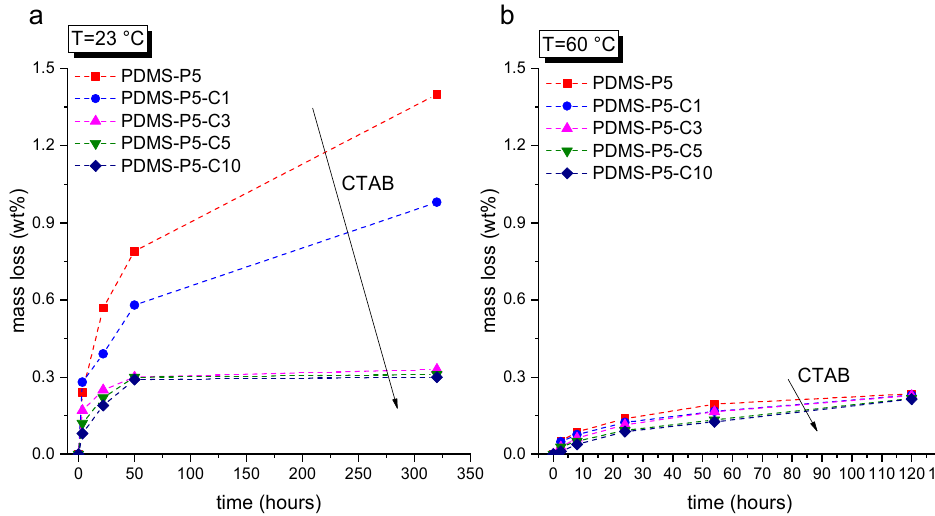
Figure 2. Mass loss as a function of time from bulk samples (thickness = 3 mm) due to paraffin leakage: ( a ) tests at room temperature (23 °C); ( b ) tests at 60 °C.